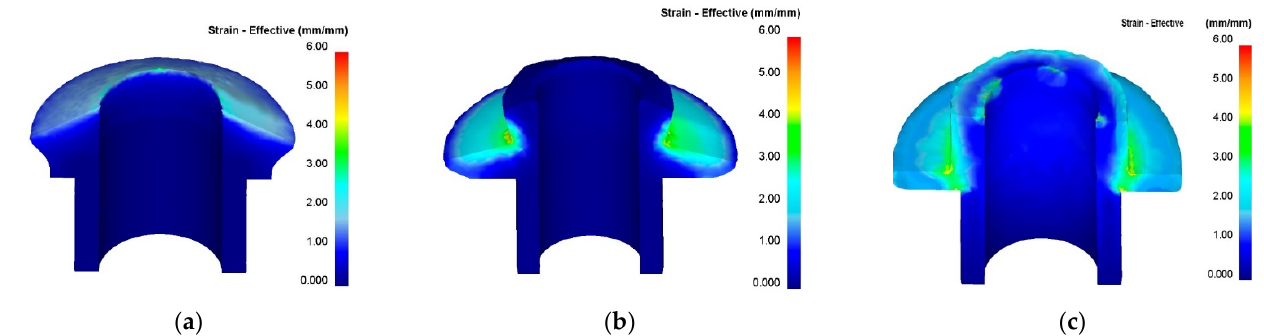
Figure 10. Distribution field of effective strain values of the workpiece at three stages of its deformation: ( a )—the first stage of rolling out, angle of rolls β 1 = 30°; ( b )—the second stage, β 2 = 15°; ( c )—the third stage, α = 45°.